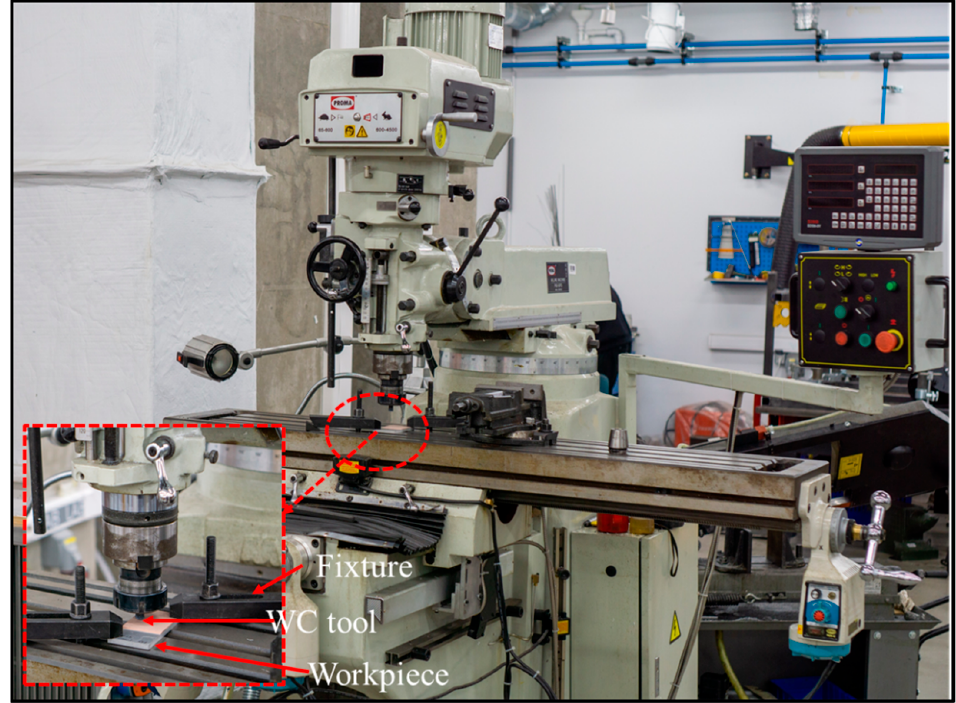
Figure 1. Experiential setup for friction stir processing.